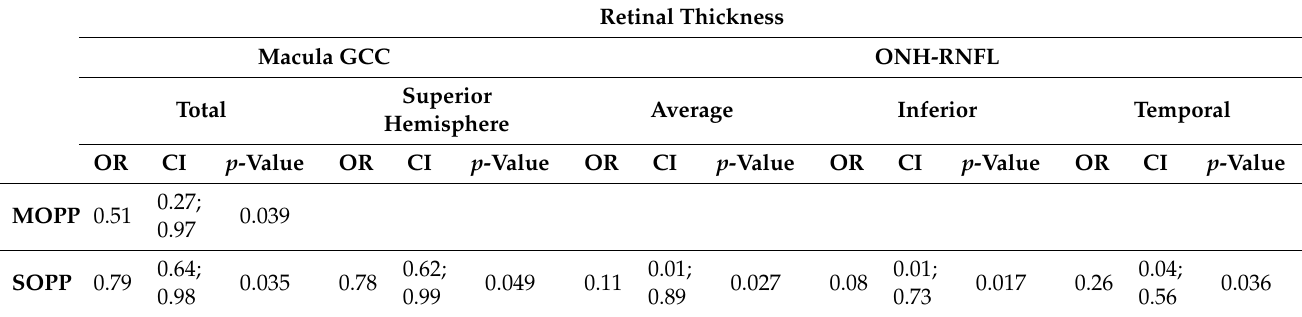
Figure 3. A forest plot showing the effect size of the comparison of (ONH-RNFL) layers and (GCC-macula) layers between the PSH and control groups. Table 4. The significant associations between OPP and retinal thickness in young people with presumed systemic